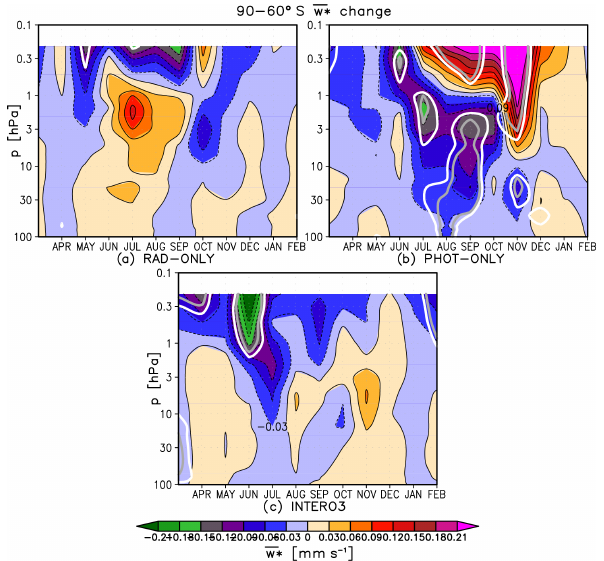
Figure 10. Schematic representation of the proposed mechanism. Yellow ovals represent changes to the SWHRs; red and blue ovals represent strengthening and weakening of zonal mean zonal wind, respectively. The green arrow indicates changes in ozone along the meridional circulation, the wavy black arrows the propagation of planetary waves (increased/decreased as given by the plus/minus signs), and the dotted green line an interaction between ozone and planetary waves. The dashed horizontal lines indicate tropopause and stratopause, and the grey areas in (a, c) indicate the regions covered in polar